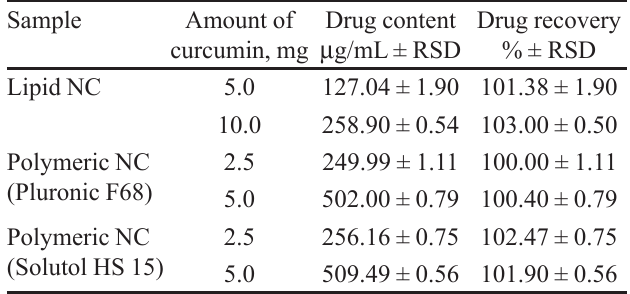
TABLE III - Drug content and drug recovery results obtained after curcumin quantitation of the nanocapsule